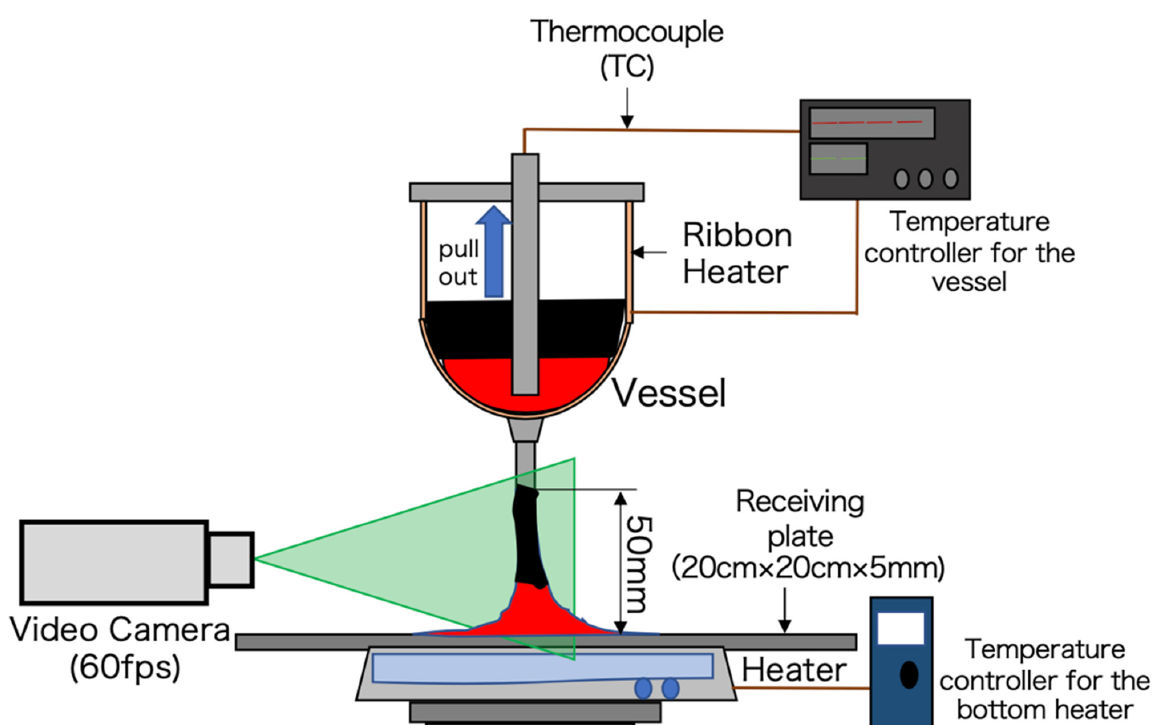
Figure 1. Schematic illustration of the test facility.